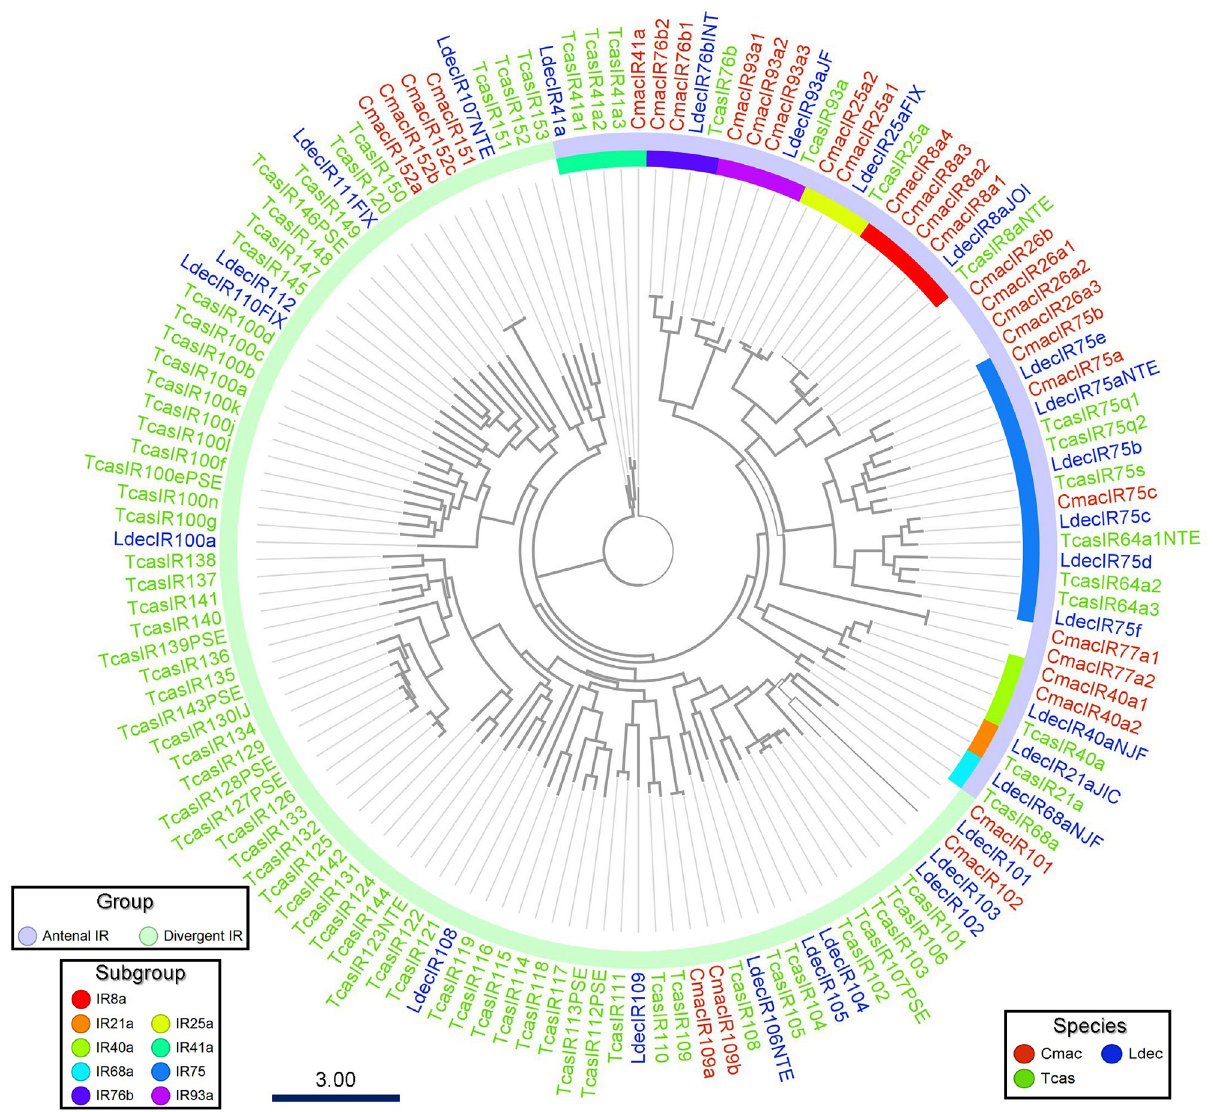
Fig 3. Maximum-likelihood phylogenetic tree of putative Callosobruchus maculatus ionotropic receptors (IRs) with Leptinotarsa decemlineata (Ldec) and Tribolium castaneum (Tcas) IR sequences. Thick nodes are supported by a bootstrap value > 60%. The rate of amino-acid substitutions per site is shown in the scale